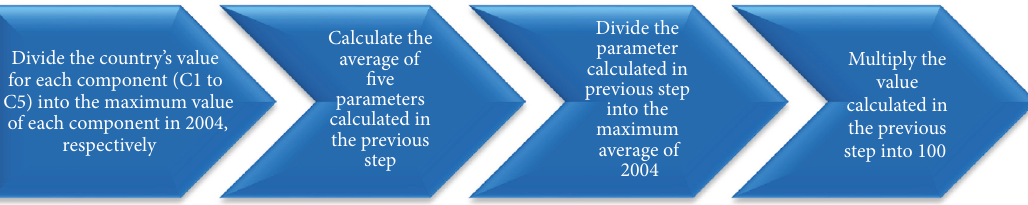
Figure 11: Process of calculating LSCI for a country.